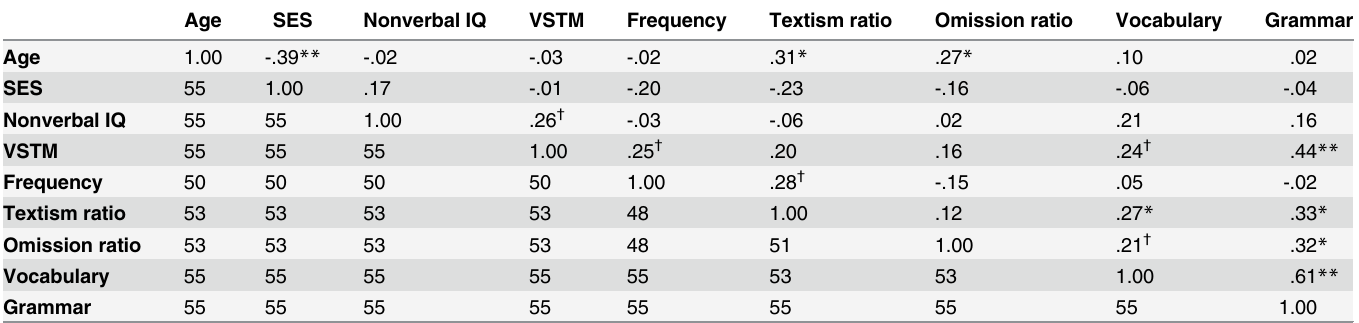
Table 7. Correlation matrix of children ’ s background measures, use of textese, frequency of texting and performance on the language